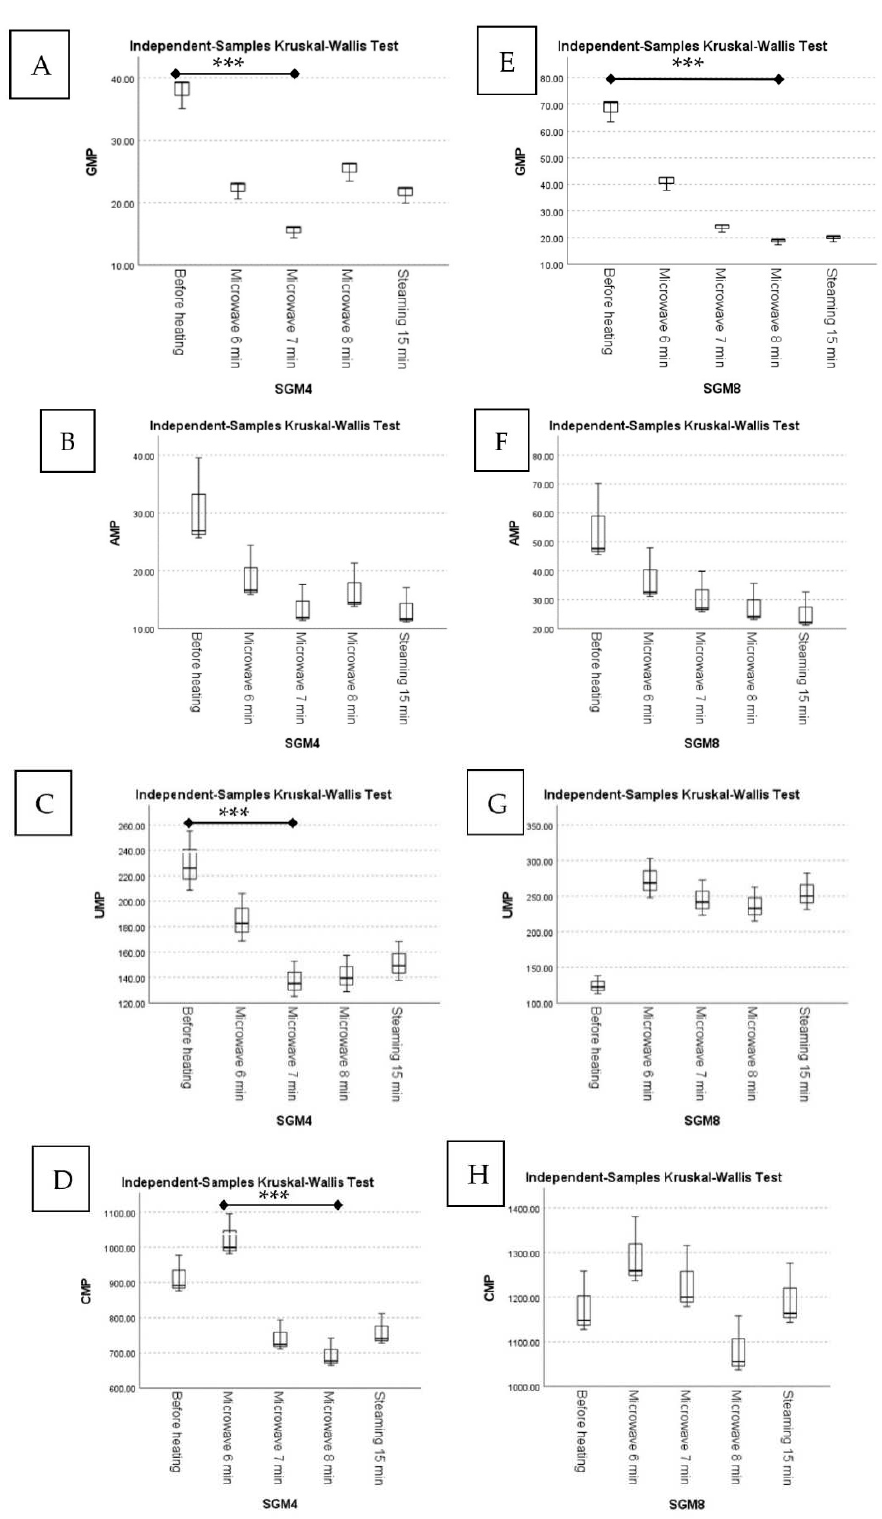
Figure 9. Boxplots of ( A ) 5′-GMP, ( B ) 5′-AMP, ( C ) 5′-UMP, and ( D ) 5′-CMP of SGM4 before and after